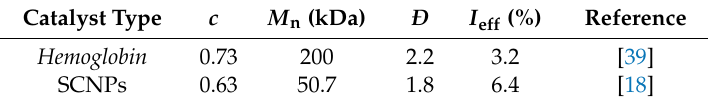
Table 2. Comparison of cysteine (Cys)-blocked bovine Hemoglobin and SCNPs for the synthesis of high molecular weight poly( N -isopropyl acrylamide) (polyNIPAM) via controlled/living radical polymerization in